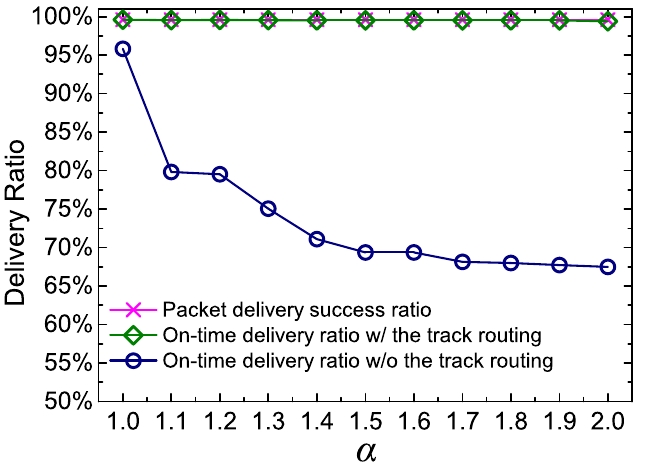
Figure 13. Delivery ratio of DERM with and without the track routing ( v M = 2 m/s, D s = 120 s, and the pause time is 30